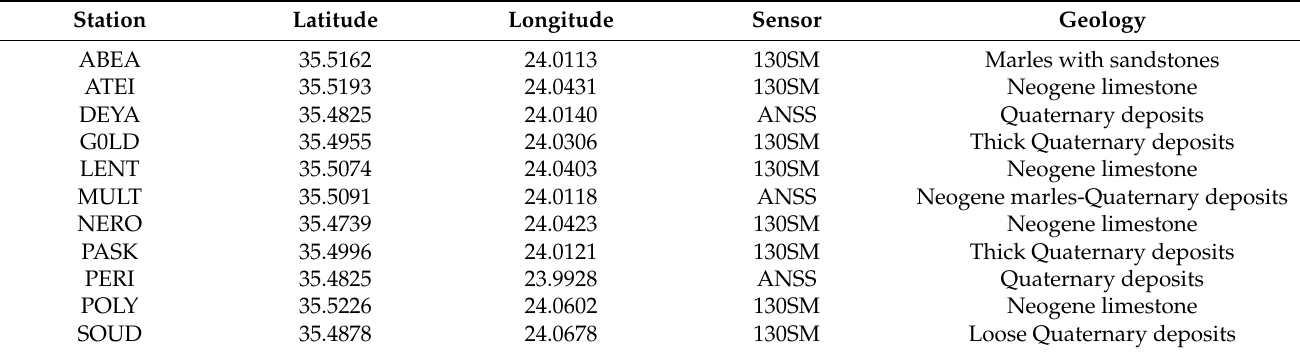
Table 1. Strong ground motion sensors’ location, type and underlying